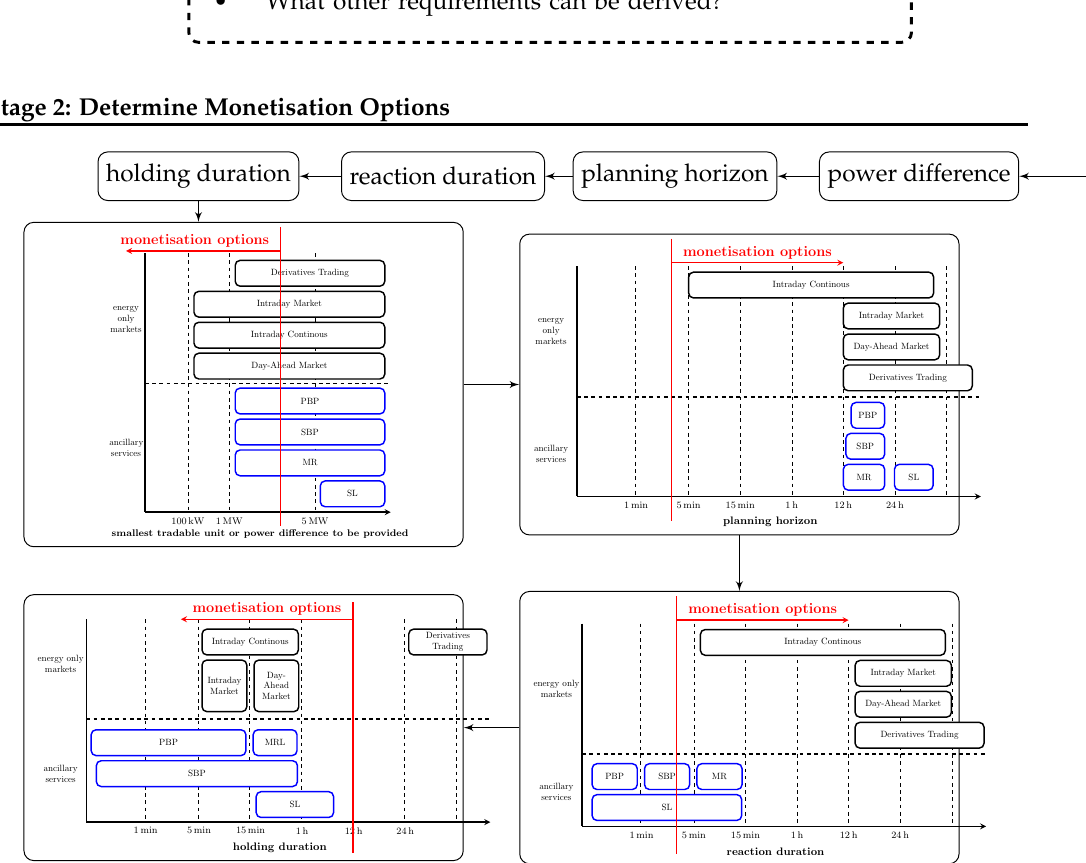
Figure 7. Methodology for the classification and characterisation of Industrial Demand-Side Integra- tion Measures: In stage 1, the use case is defined (see Sections 3.1.1–3.1.3), in stage 2, monetisation options are determined (see Sections